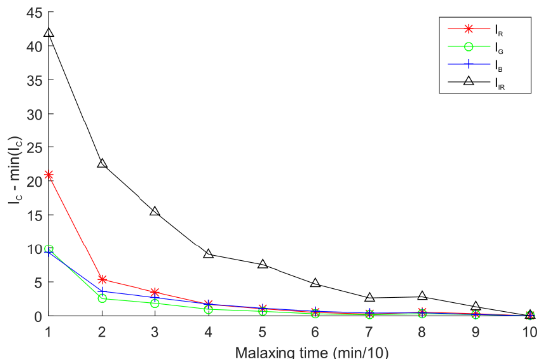
Figure 11. Floating oil index for different channels versus malaxing time.